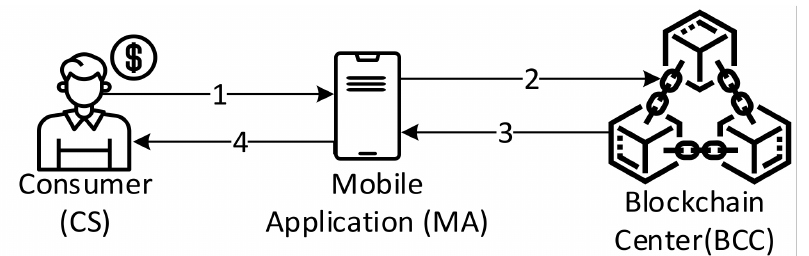
Figure 12. Consumer checking tobacco in the verification